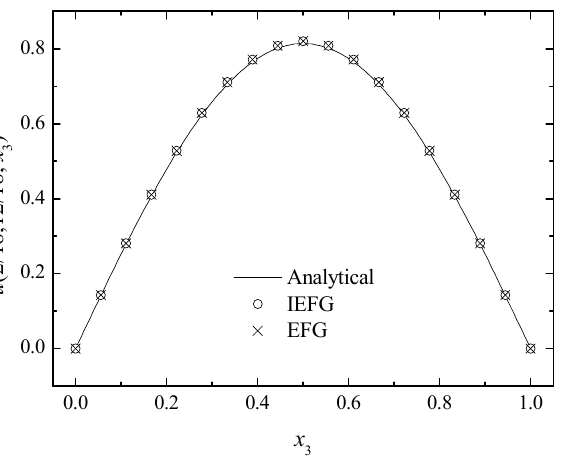
Figure 19. The comparison of the numerical and analytical solutions of the two methods along the x 3 -axis.